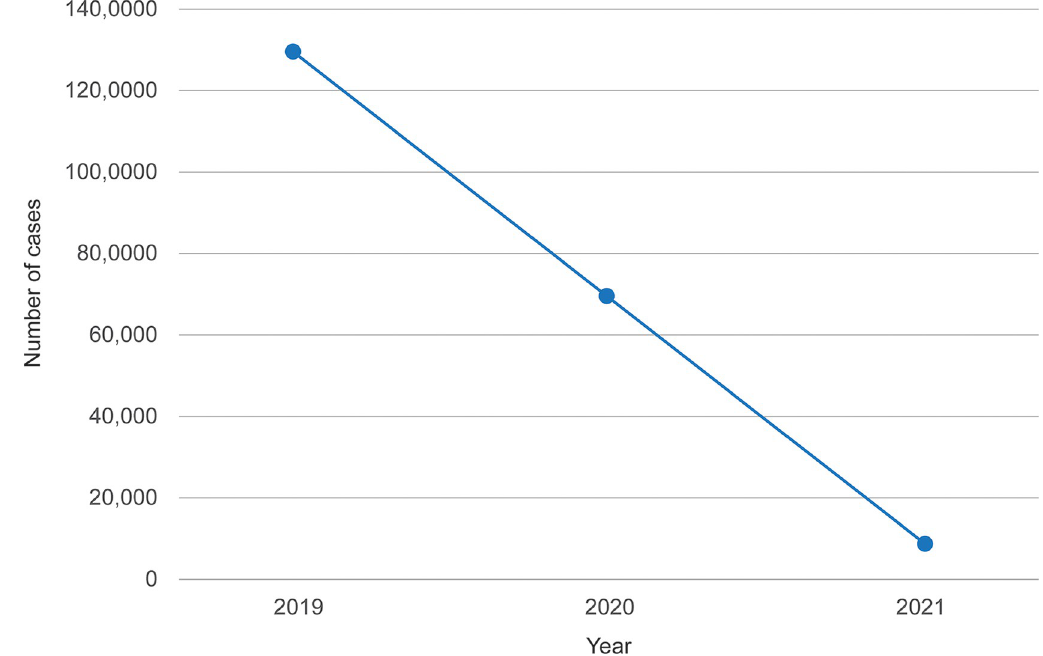
Fig 1. Number of dengue patients in Thailand between 2019 and